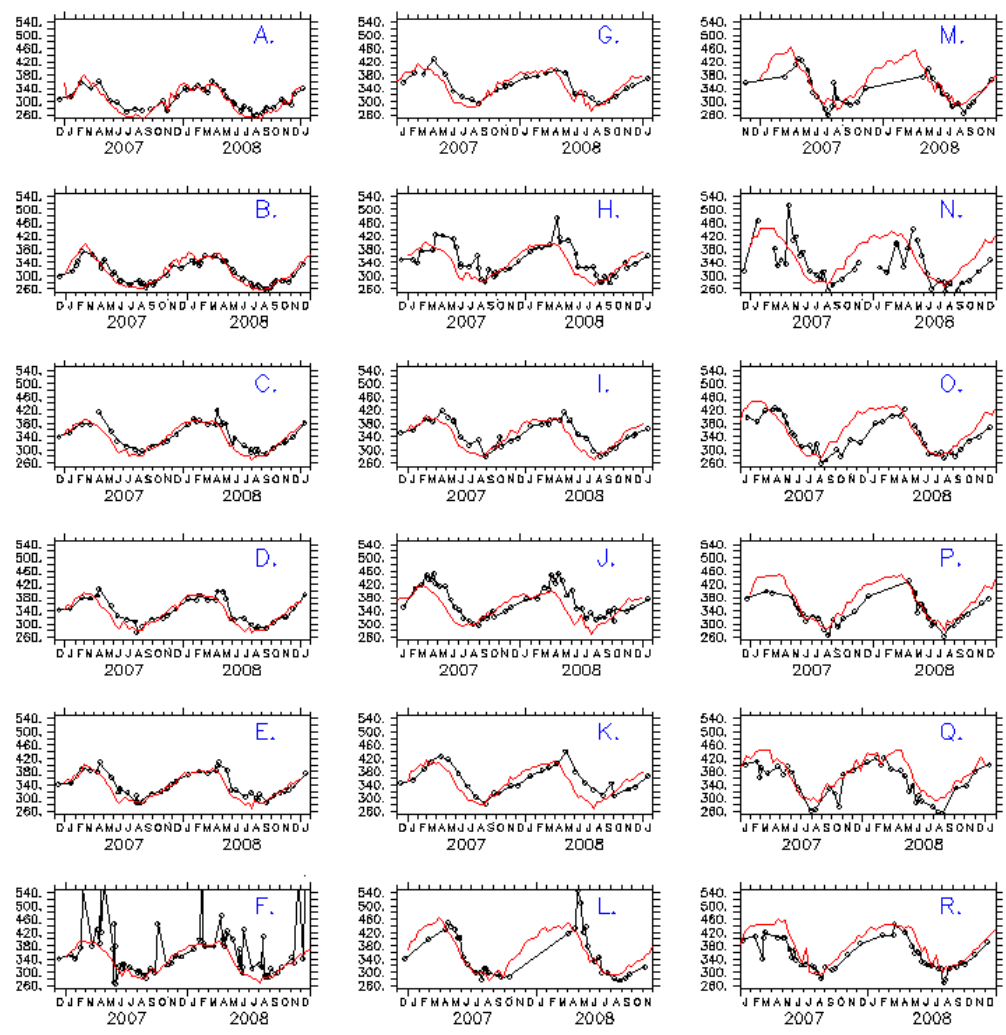
Fig. 11. Seasonal variability of DO in surface layer. Notations same as in Fig.